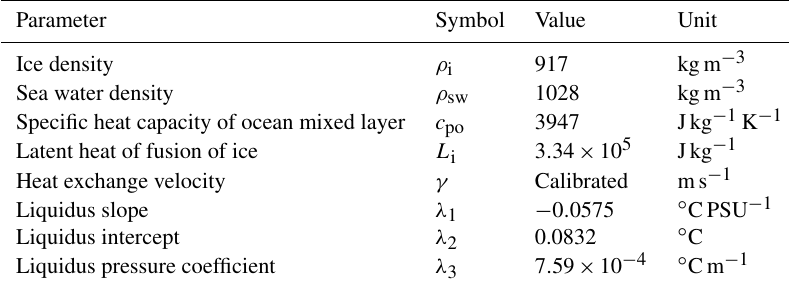
Table 4. Physical constants.